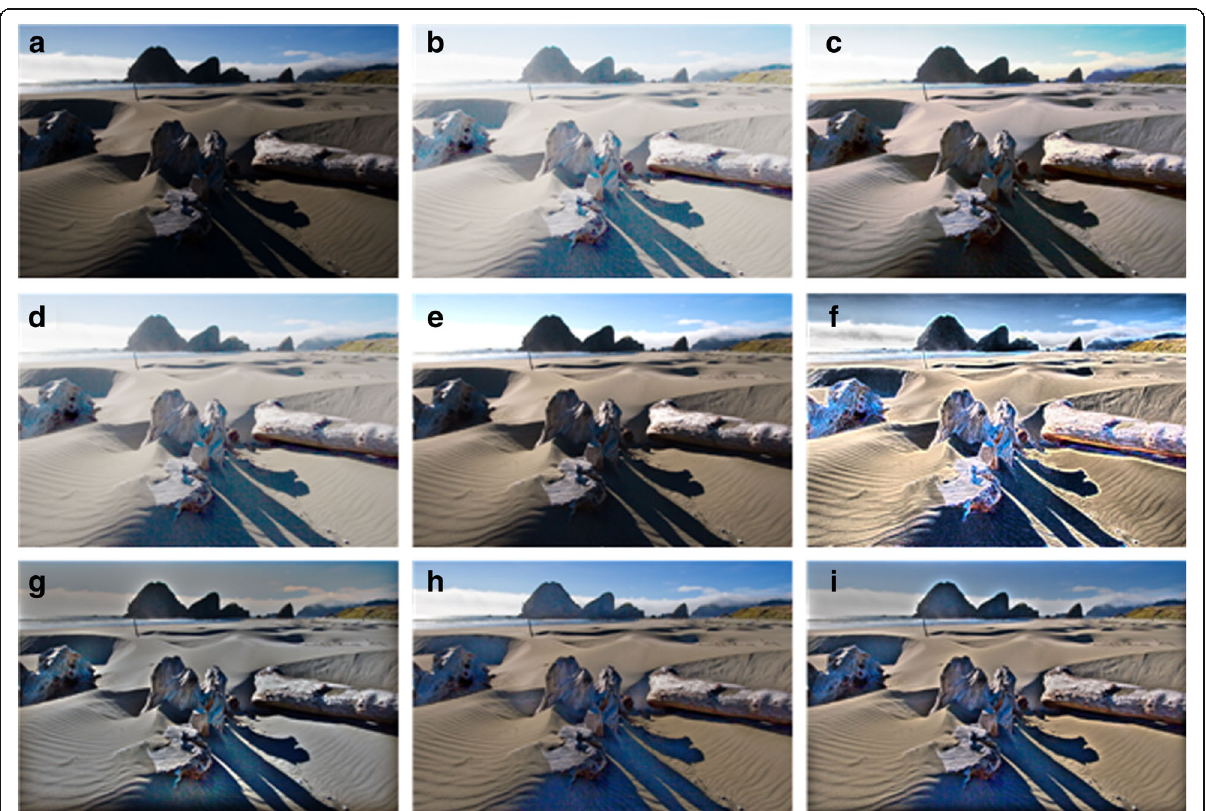
Fig. 4 Experimental results on beach. a Original image; b MSR; c LHE; d AL; e ALTM; f GUM; g SARV; h NPE; i